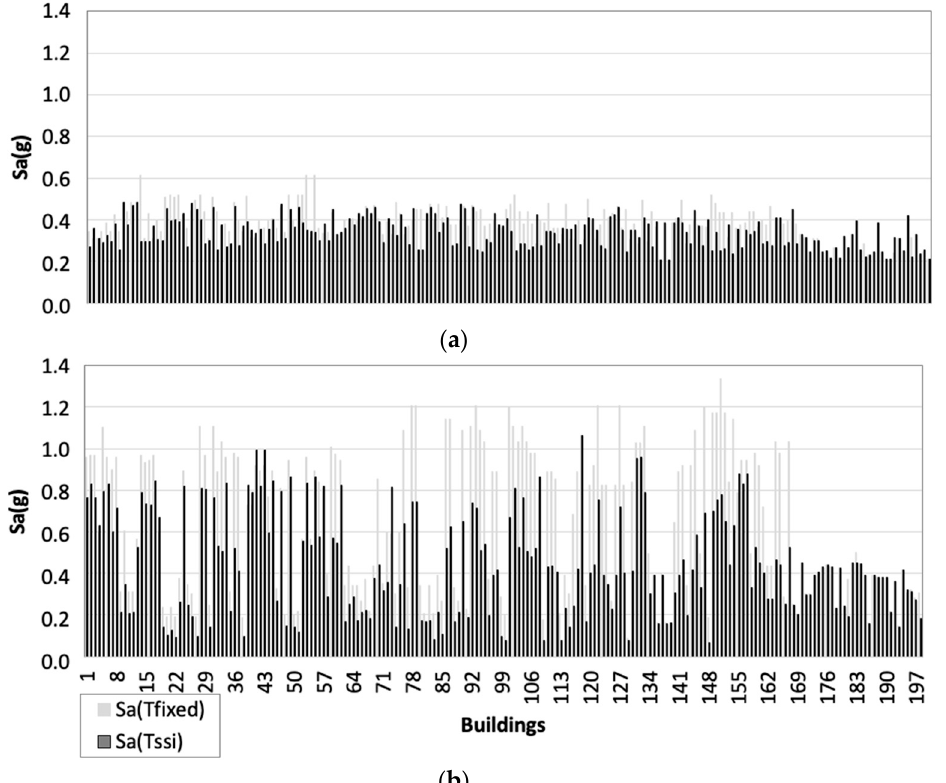
Figure 17. Spectral accelerations S a ( T SSI ) and S a ( T fixed ) evaluated for each building of the north Old Town area (shown in Figure 18c) for ( a ) 1818 input; ( b ) 2018 input.